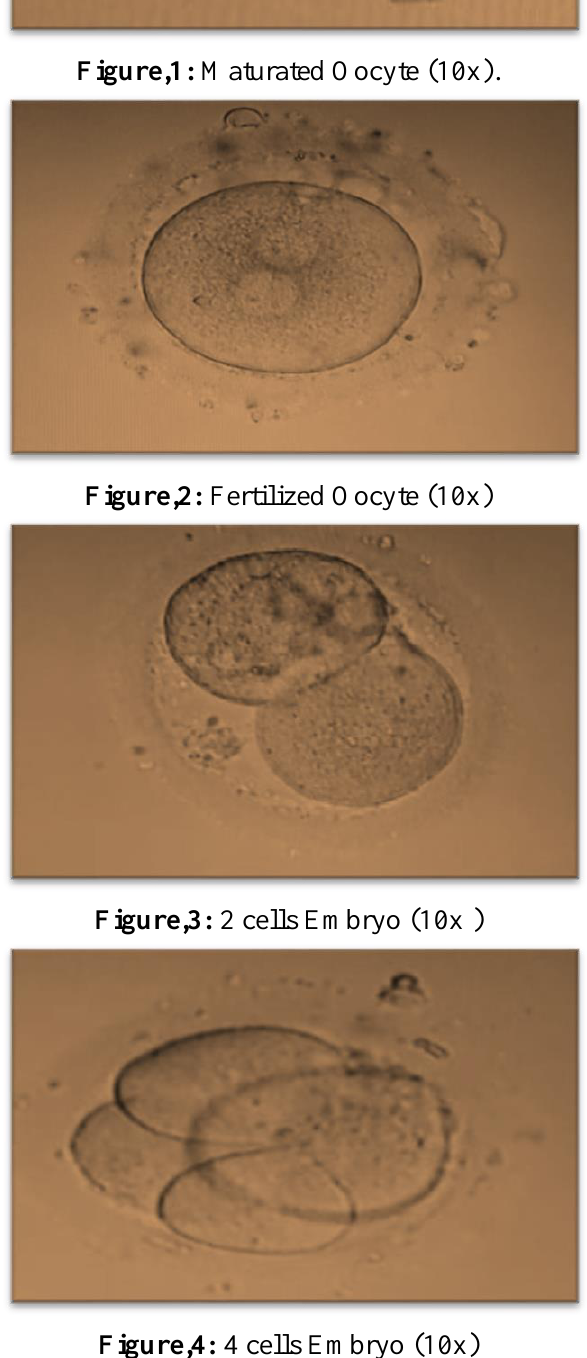
Figure,4: 4 cells Embryo (10x)